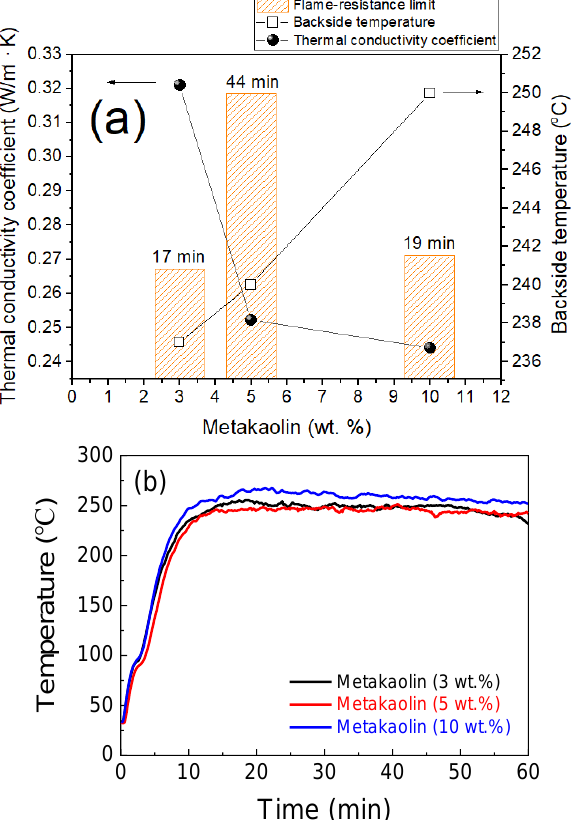
Figure 9. ( a ) Thermal conductivity, backside temperature for steel substrate, flame-resistance limit with respect to different contents of metakaolin, and ( b ) flame-resistance rating of the MKPCs. (magnesia/KH 2 PO 4 molar ratio equals to 4; wollastonite:vermiculite = 20:10 wt.%; aluminum trihydroxide = 10 wt.%).